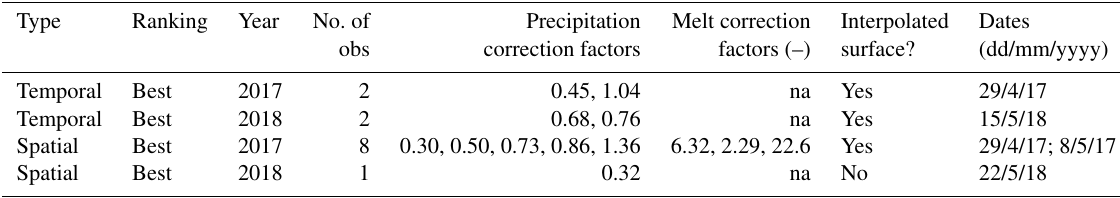
Table 4. Correction factors from the assimilation scheme for the best-ranked simulations from both water years. The model determination for precipitation vs. melt correction factors is included and whether the Barnes objective analysis created a spatially distributed correction surface. Note: na – not